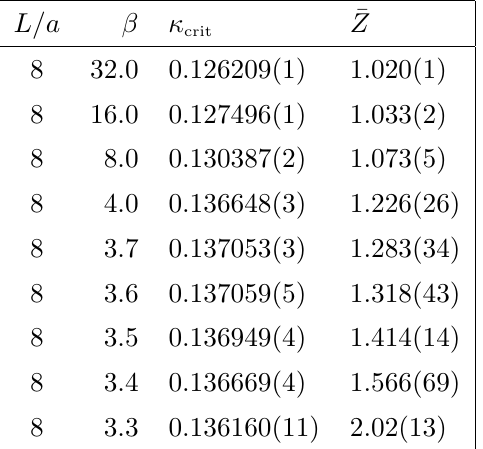
and slopes (cid:22) Z at the unitary point, obtained crit Lm < 0 : 22, see table 2. The resulting uncertainty is j j